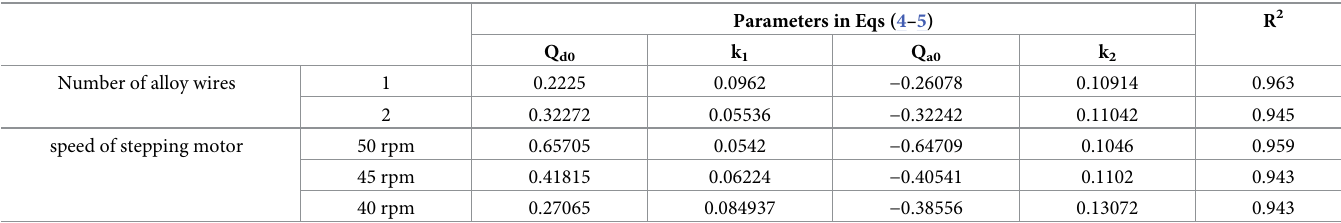
Table 4. Coefficients of heat production expression and determination coefficients of the nitinol wire surface